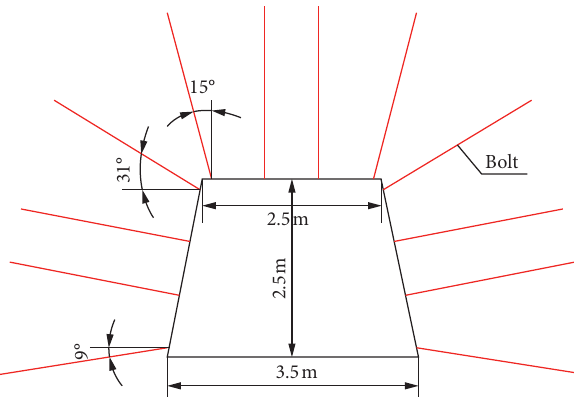
Figure 9: Cross section of the bolt support.